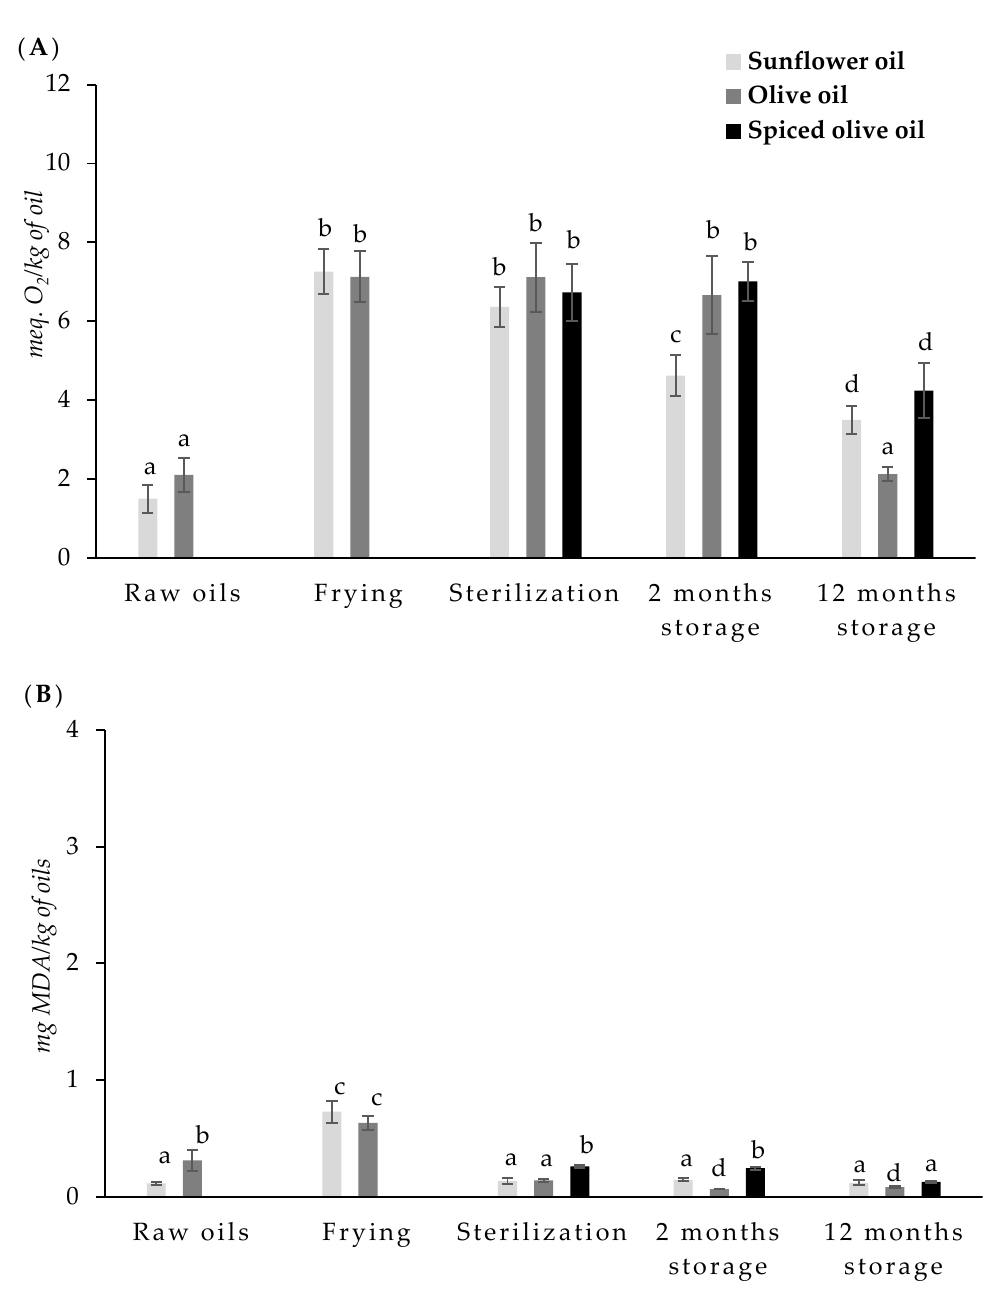
Figure 3. Peroxide values (PVs) (meq. O 2 /kg of the sample) ( A ) and thiobarbituric acid reactive substances (TBARS) values (mg malonaldehyde/kg of the sample) ( B ) of oils in each step during the canning process and at 2 and 12 months of stored. a–d - Mean values with different letters are significantly different ( p < 0.05).